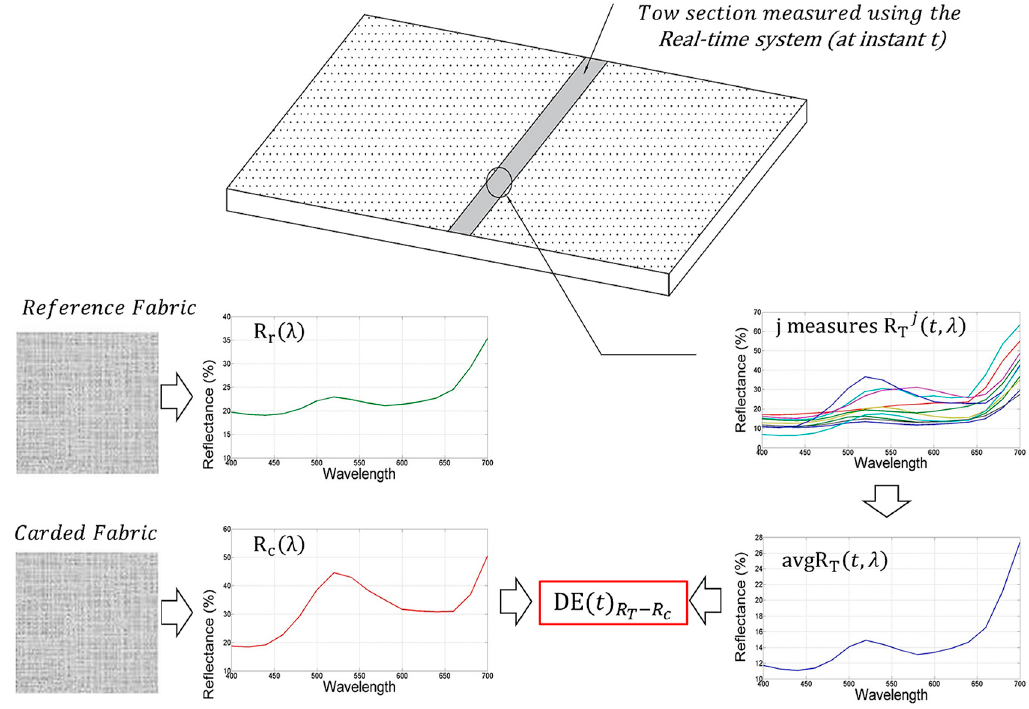
Figure 7. Measurement of the CMC(2:1) color distance between Carded fabric, measured in Lab, and tow measured at instant t using the real-time colorimetric system.